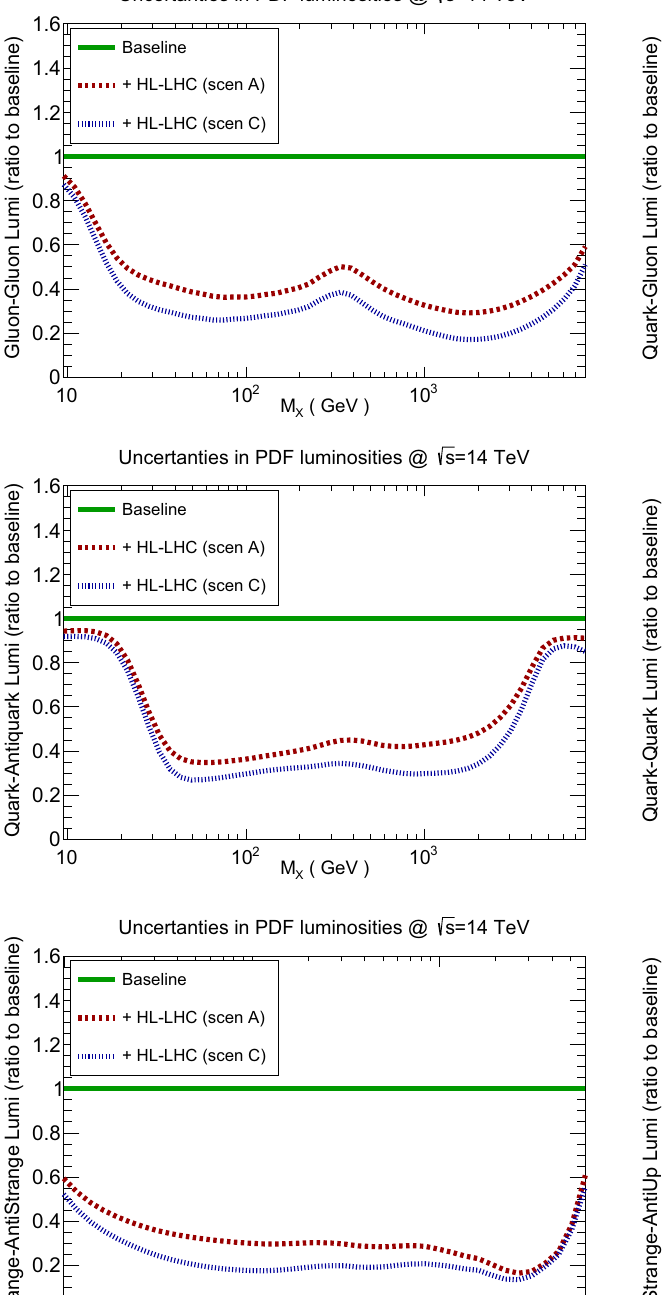
s ¯ u luminosities for the conservative (A) and optimistic (C) scenarios. The average values for the PDF uncertainty reduction in different bins of M X is also reported in this